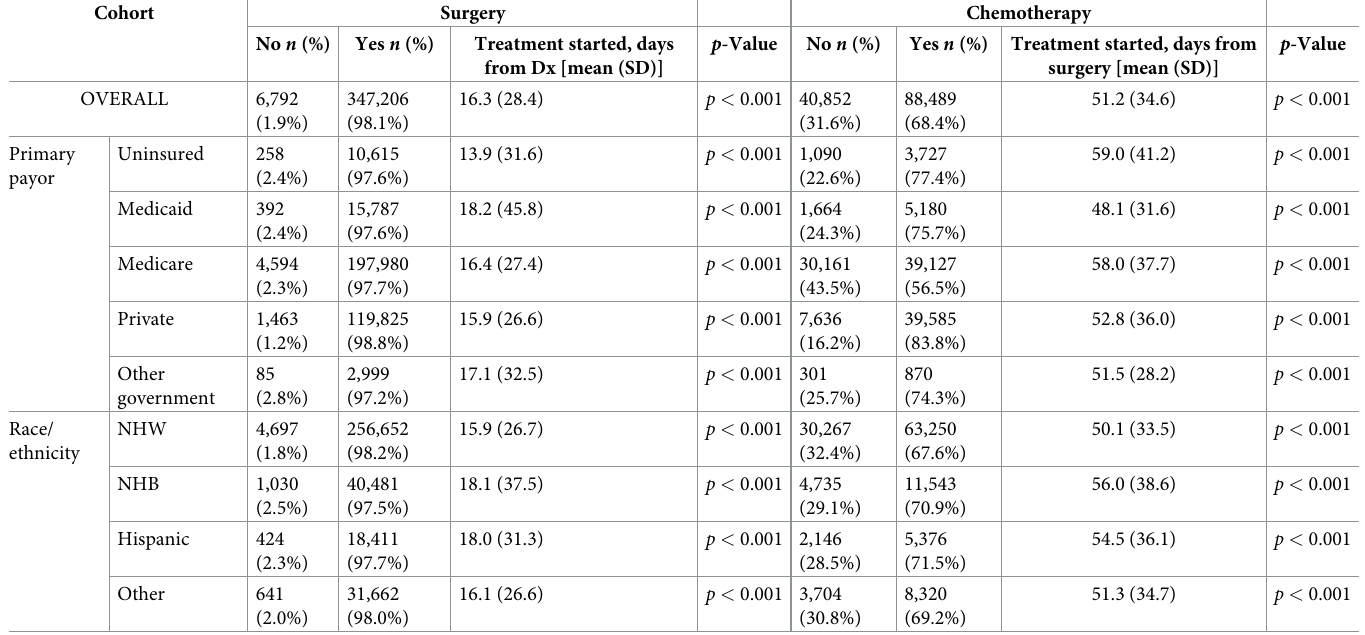
Table 2. Receipt of treatment by insurance and race/ethnicity. Cohort